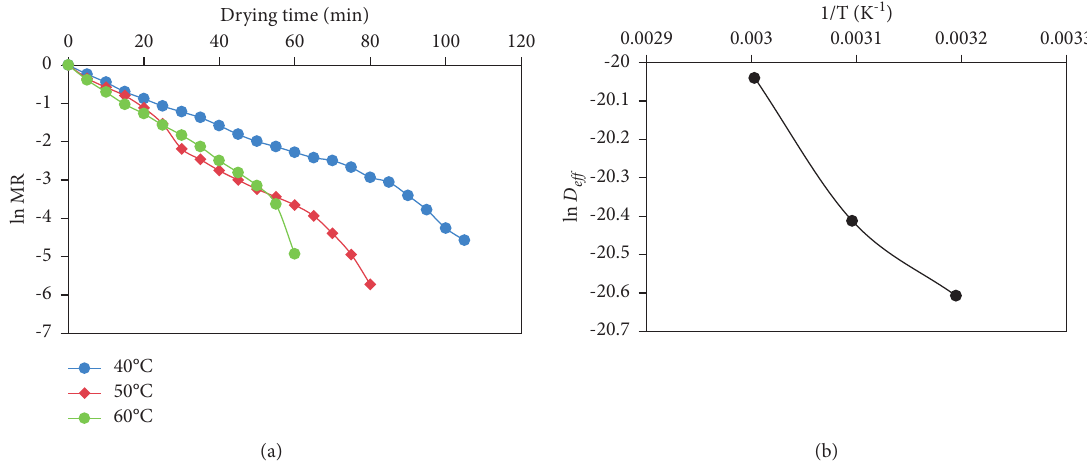
Figure 6: (a) Experimental ln MR with time at different temperatures. (b) Plot for determination of activation energy. Table 7: D eff , E a , and mass transfer constraints of pumpkin seeds at different drying temperatures. Temperature ( ° C) D eff (m 2